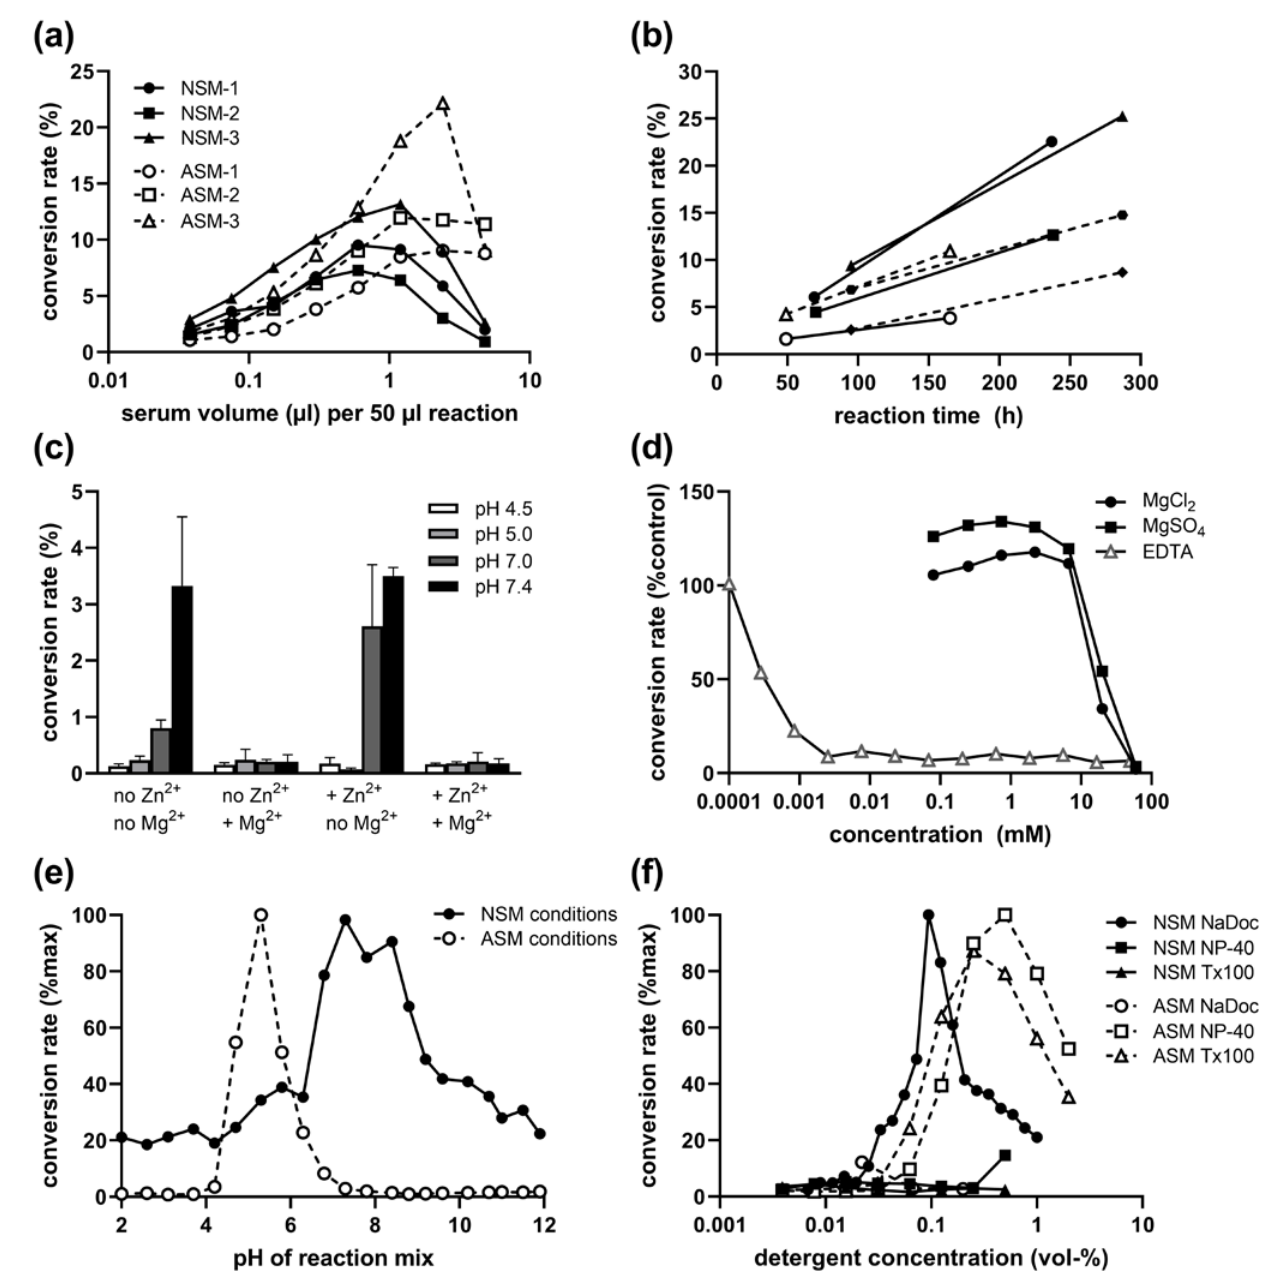
Figure 1. Optimization of reaction conditions for NSM in human serum samples. ( a ) Sample volume dependence for three representative samples (1–3) for ASM (16 h reaction time) and NSM (100 h). ( b ) Time dependence of serum NSM in different samples. ( c ) pH-dependent influence of 500 µM Zn 2+ and 200 mM Mg 2+ addition on ASM and NSM activity (reaction mix with 0.1% NaDoc). ( d ) Inhibition of serum NSM activity by Mg 2+ and EDTA. ( e ) pH profile for ASM (NP-40, Zn 2+ ) and NSM (NaDoc) conditions. ( f ) Influence of detergents for ASM and NSM conditions. NaDoc sodium deoxycholate, NP-40 Nonidet P-40, and Tx100 Triton X-100 detergents.